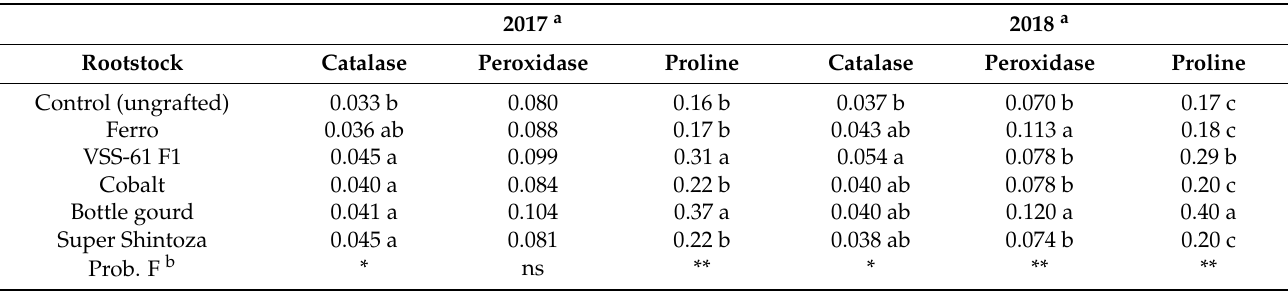
Table 5. Means of catalase and peroxidase activities (mmol H 2 O 2 g − 1 FW min − 1 ) and proline contents (mg kg − 1 of fresh weight) in the leaves of Gianco F1 cucumber plants grafted onto five cucurbit rootstocks and the ungrafted control under heat and salinity stresses in the 2017 and 2018 seasons. Results are expressed as percentage over dry weight. Details on the measurement of the traits presented are provided in the Material and Methods